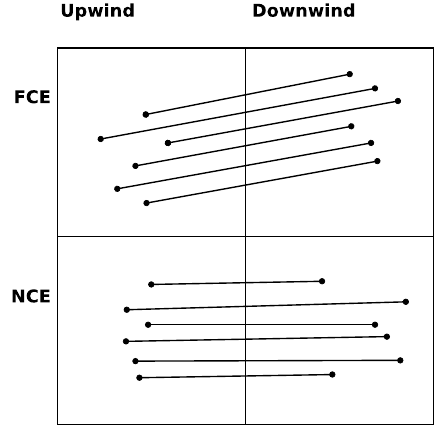
Fig. 4. Schematic depiction of the experimental mixed design. The starting and end points of the black lines refer to the critical diameter data points.